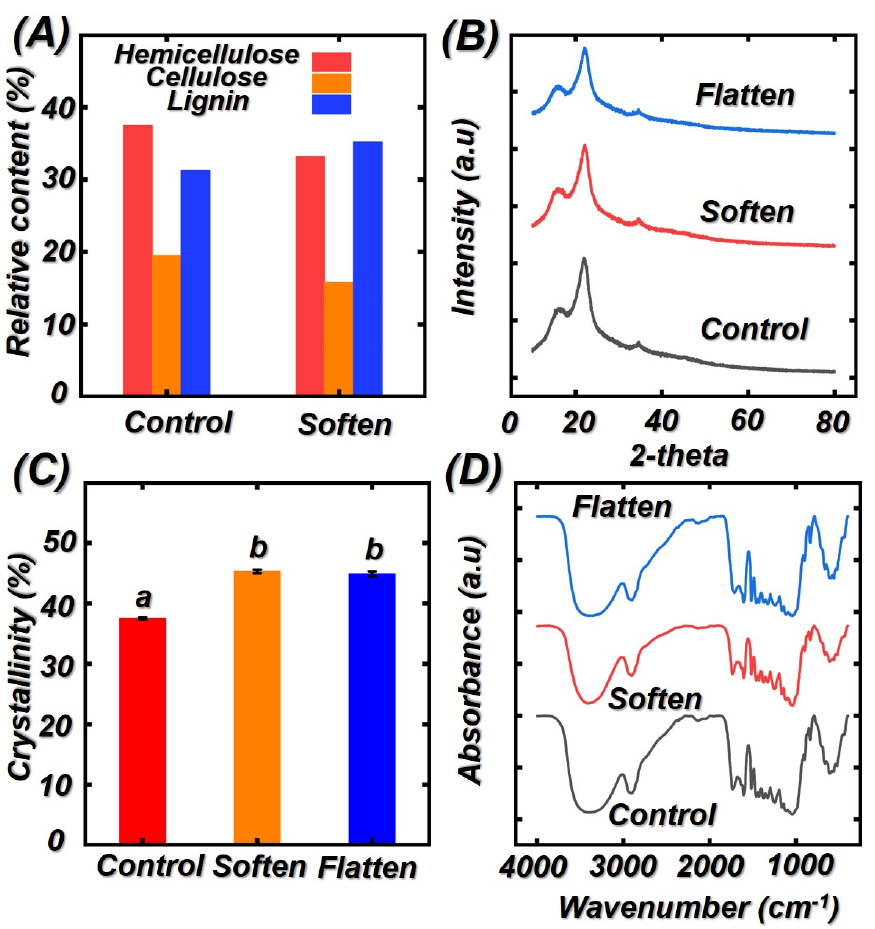
Figure 5. The change in chemical composition, cellulose crystallinity, and chemical groups of different bamboo samples: ( A ) hemicellulose, cellulose, and lignin; ( B ) XRD curves; ( C ) relative crystallinity degree; ( D ) FTIR curves of different bamboo samples. Different capital letters represent the significant difference between heat treatment groups ( p < 0.05). The error bar in the picture represents the standard deviation.